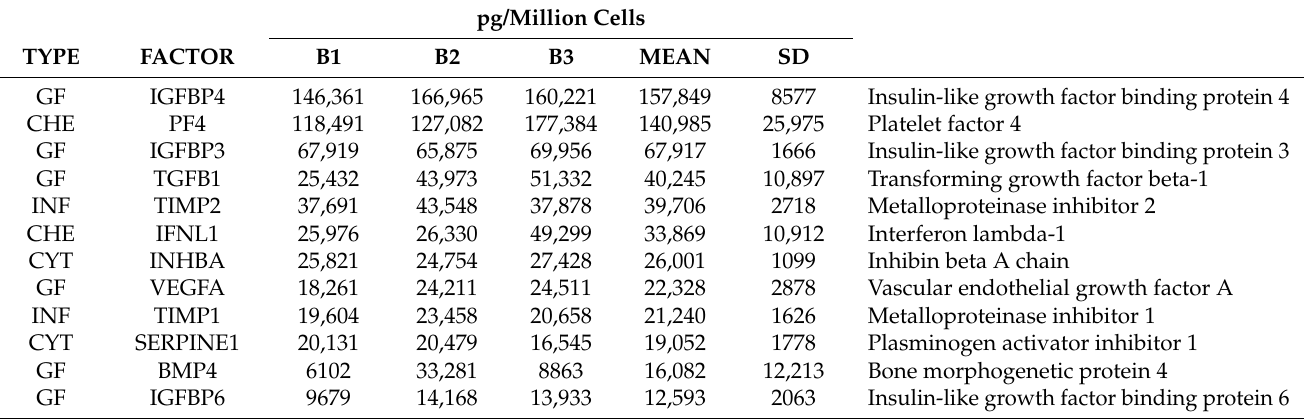
Table 2. Most abundant (>10,000 pg/million cells) secreted factors in PRP-treated BMSCs. pg/Million